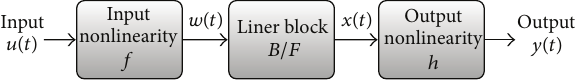
Figure 7: Hammerstein-Wiener nonlinear model